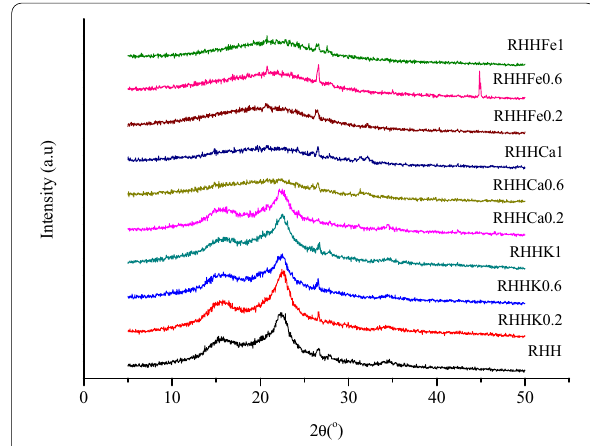
Fig. 1 XRD pattern of the rice husk